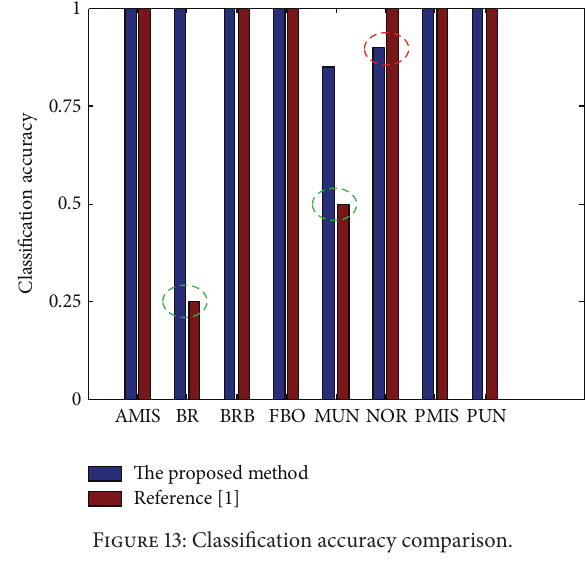
Figure 13: Classification accuracy